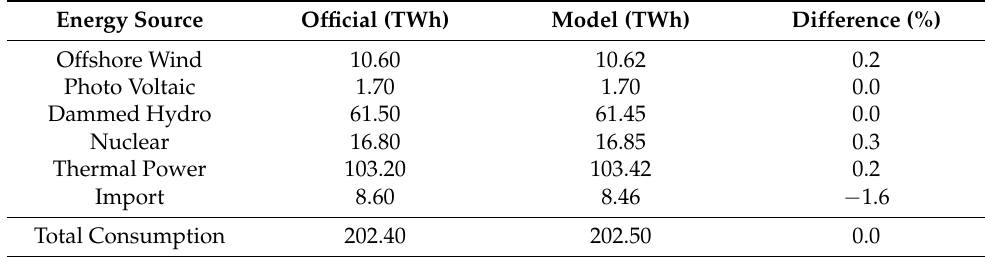
Table 4. Comparison of Guangxi’s electricity system between the official values and the simulation